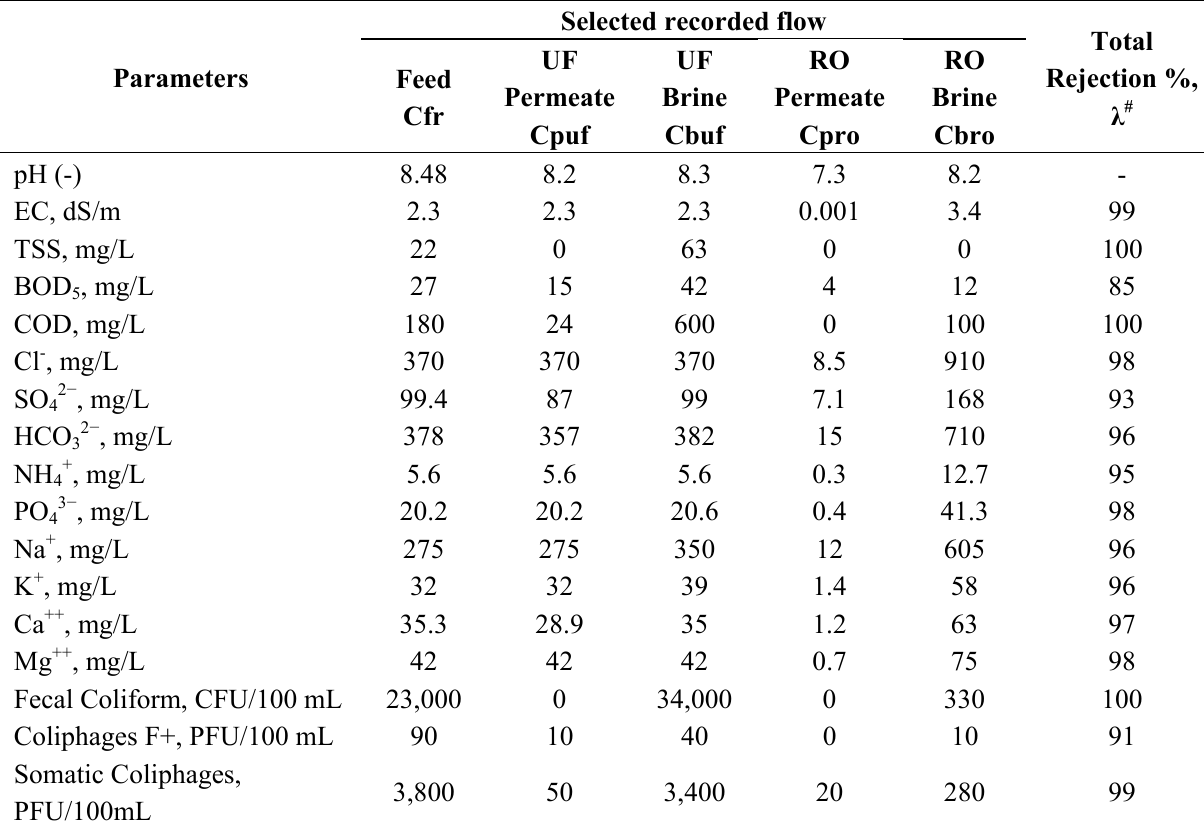
Table 6. Pilot plant water quality